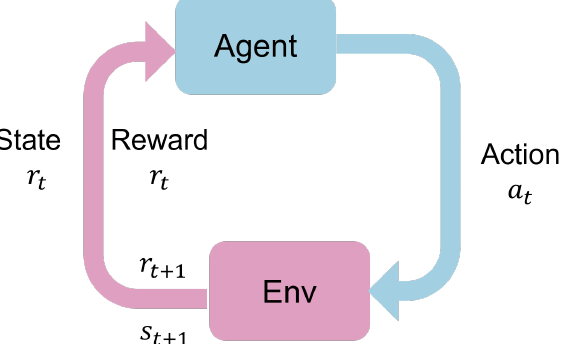
Figure 3. Markov decision